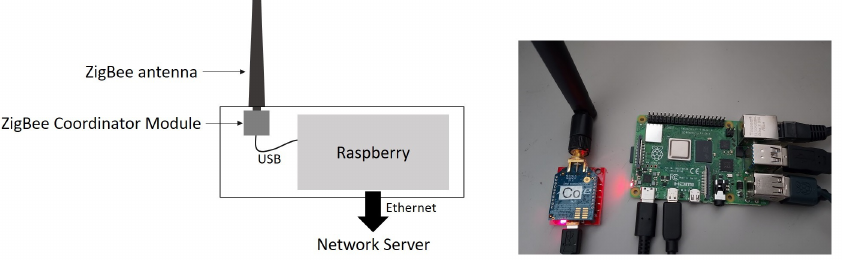
Figure 7. The gateway with the Zigbee communication module is defined as Coordinator to retrieve the data from the UAV and put them on the network